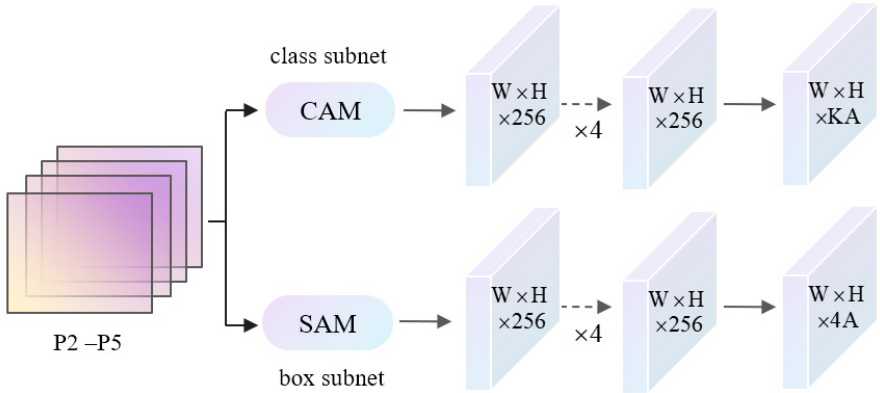
Figure 4. Subnetwork structure of feature detection.